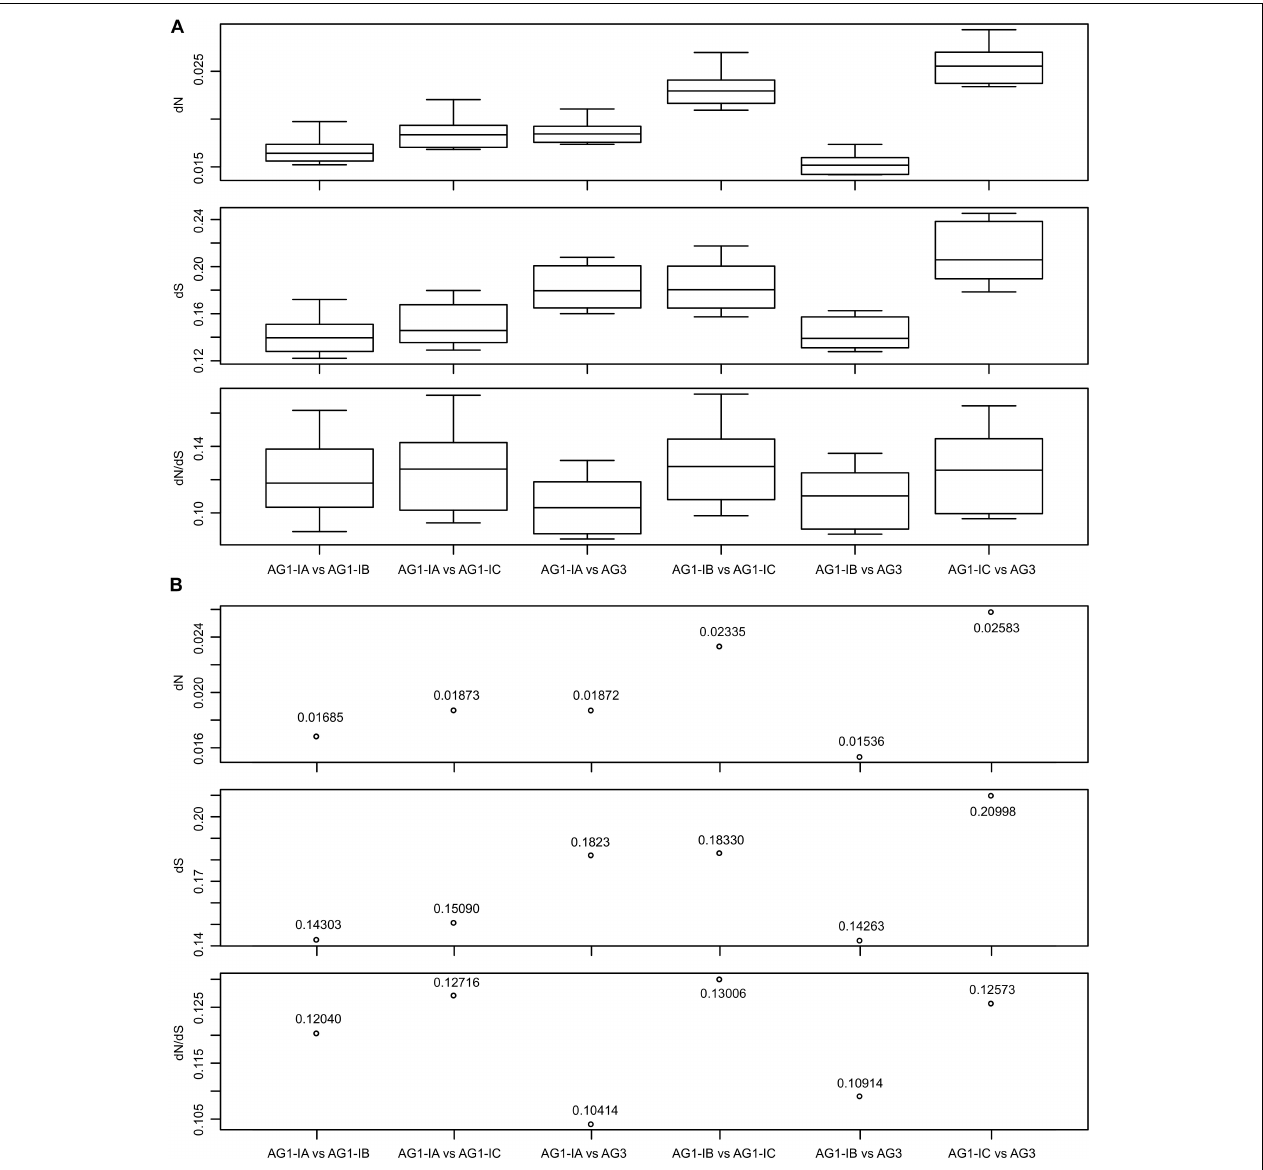
FIGURE 3 | The dN, dS, and dN/dS values for each pair of Rhizoctonia solani mitogenomes. (A) The box plots displayed the values estimated by 10 methods implemented in the KaKs_Calculator. The analysis was done based on concatenated sequences of 15 typical protein-coding genes. (B) The mean of the estimated values shown in (A)